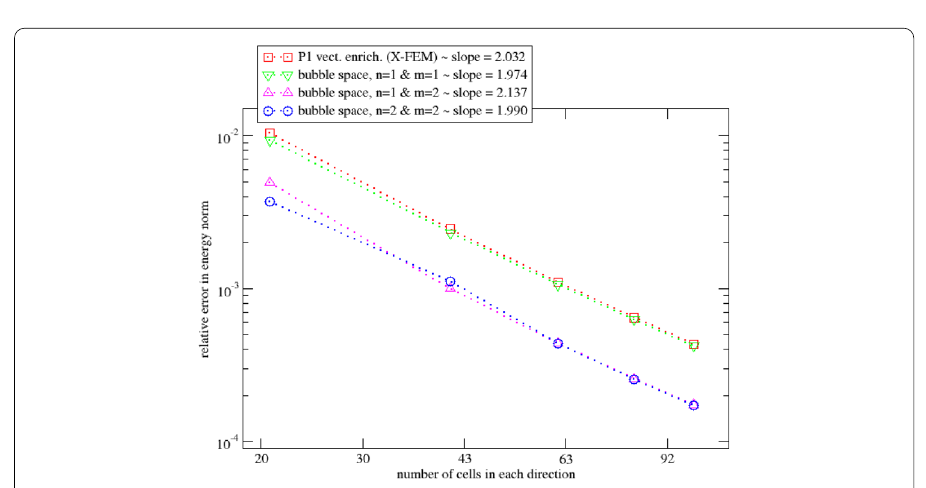
Fig. 32 Conditioning of “bubble” enrichment vs X-FEM vectorial enrichment